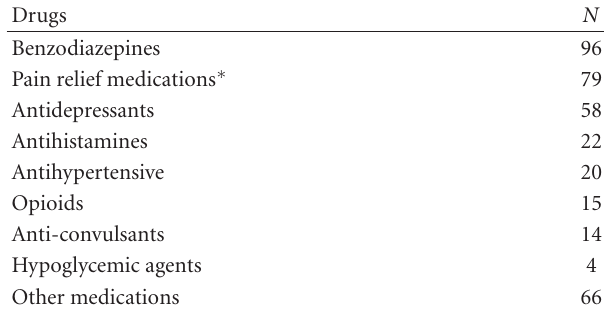
Table 1: List of di ff erent medications taken by patients.